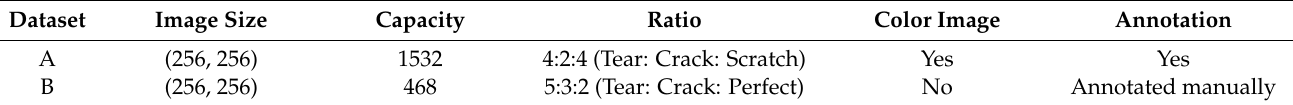
Table 2. The description of the image dataset A and